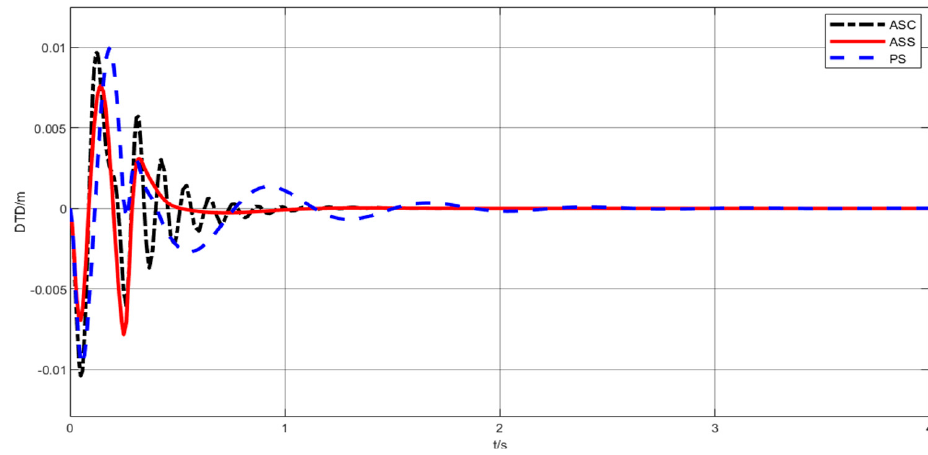
Figure 11. Bump suspension working space responses of different suspensions.